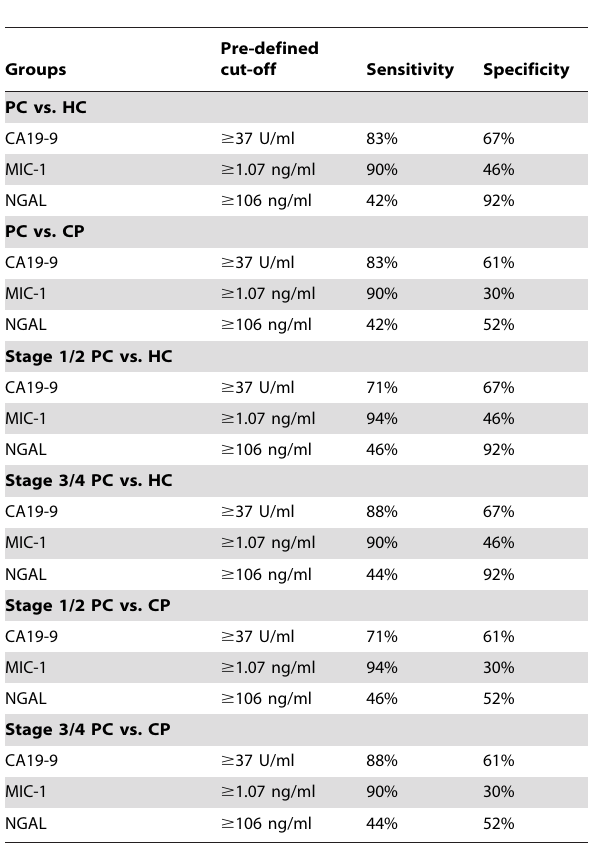
Table 3. Diagnostic potential ? of NGAL, MIC-1 and CA19-9 at pre-defined